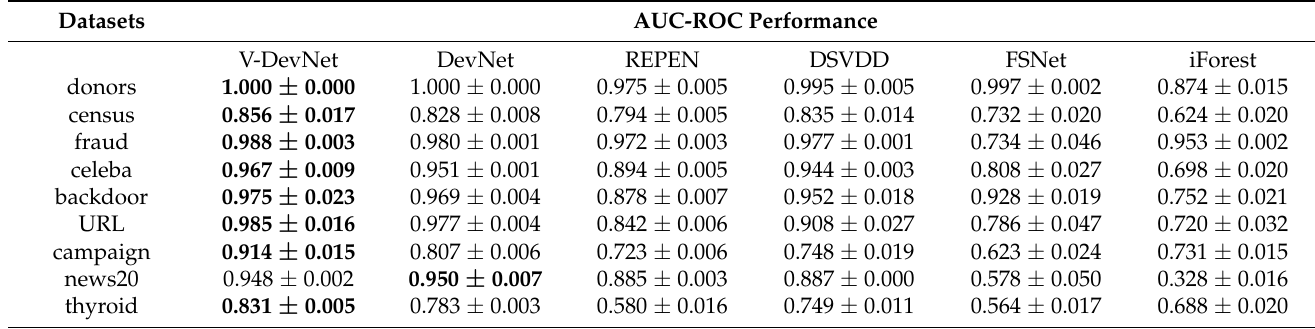
Table 1. AUC-ROC performance of V-DevNet and five competitive methods. The bolded data in the table indicates that the accuracy of the algorithm is higher compared to other algorithms.